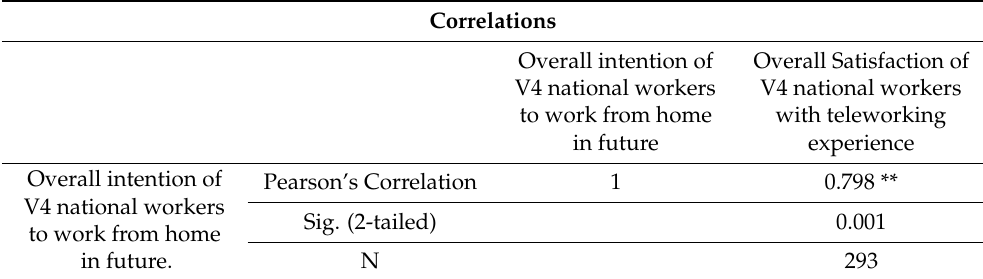
Table 7. Correlations between V4 national workers’ overall satisfaction with working from home experience during COVID-19 lockdown and their intention to work from home in the future.